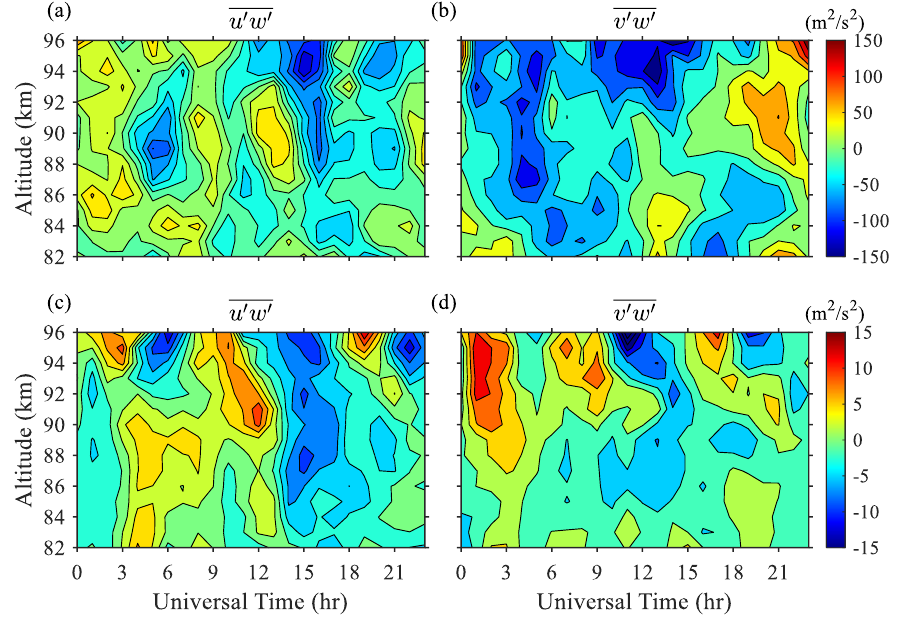
Figure 2. Altitude-time variation of the zonal ( a , c ) and meridional ( b , d ) momentum fluxes calculated by ( a , b ) the MCD method and ( c , d ) the compositing tides and the PWs during January 2012.